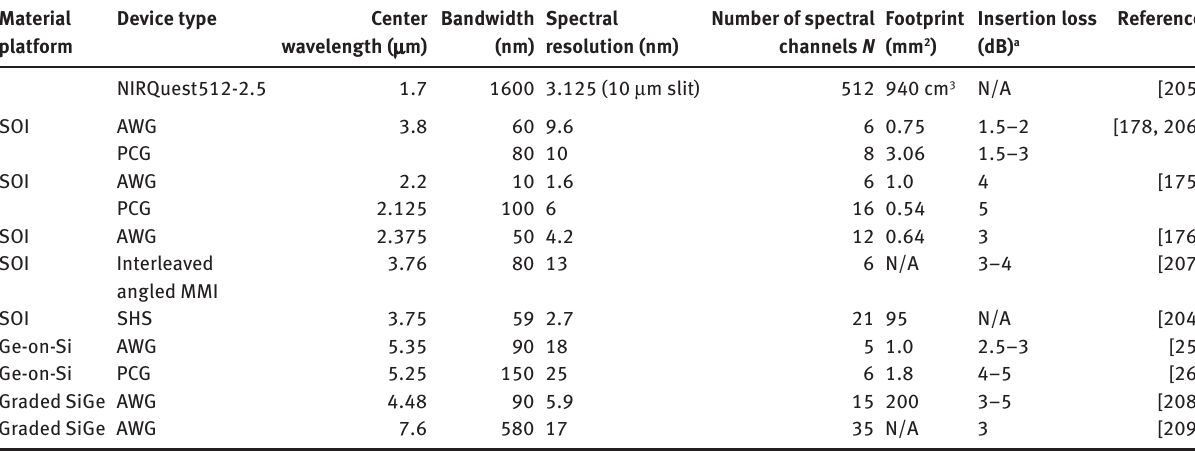
Table 6: Mid-IR on-chip waveguide spectrometers; specifications of a COTS portable spectrometer (Ocean Optics NIRQuest512-2.5) are also listed for comparison. Material